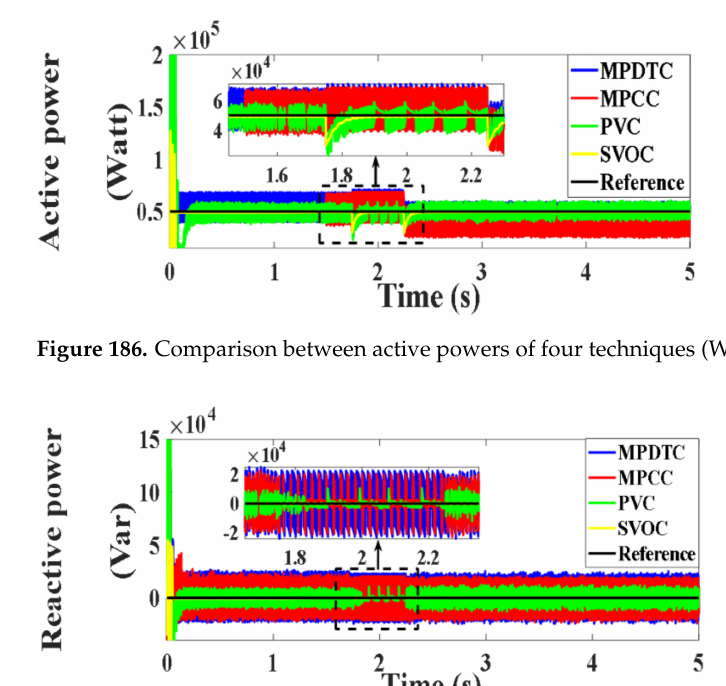
Figure 185. Prime mover operating speeds (rad/s).